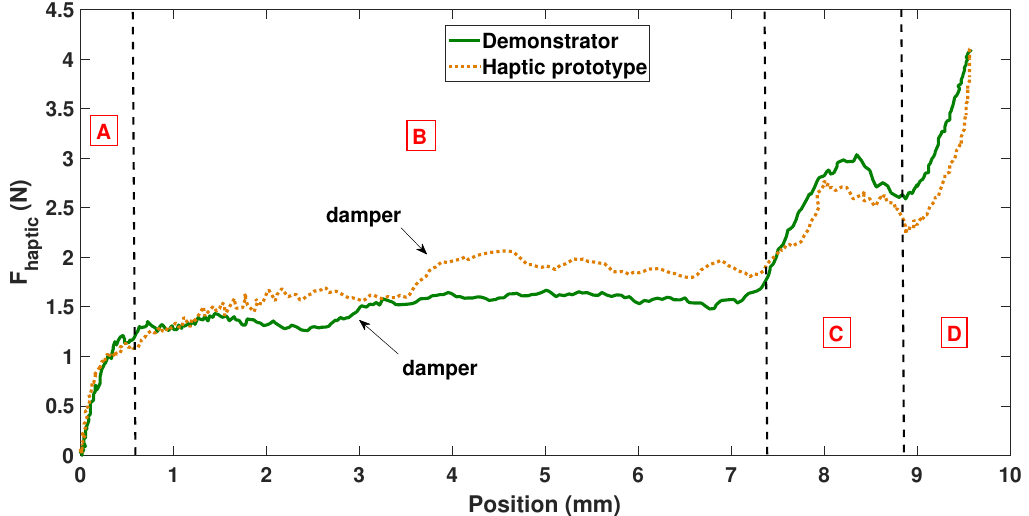
Figure 23. Haptic force measured on the Renner R (cid:13) demonstrator of Figure 1 and on the prototype of Figure